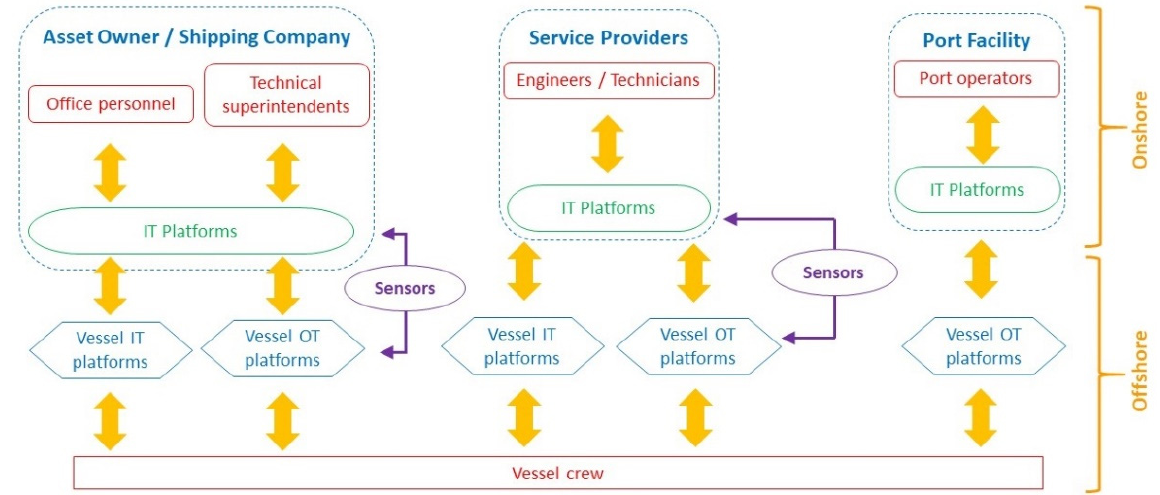
Figure 2. Communication paths of shore-based and vessel-based stakeholders and IT/OT platforms.